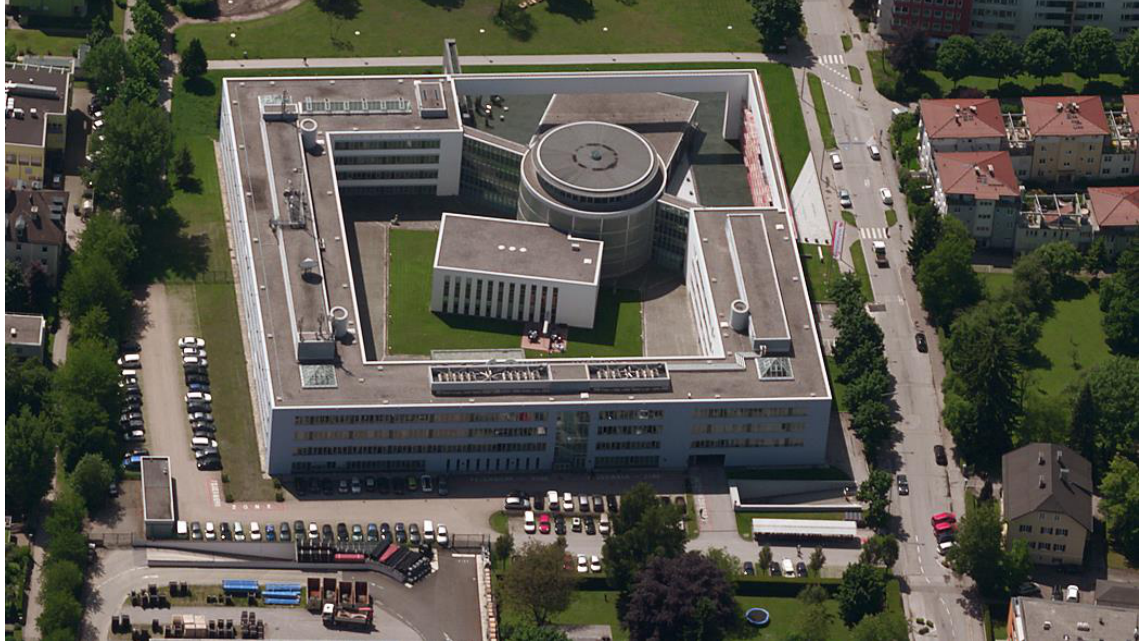
Figure 4: Forward looking oblique image taken from 900 m above ground level (Salzburg,